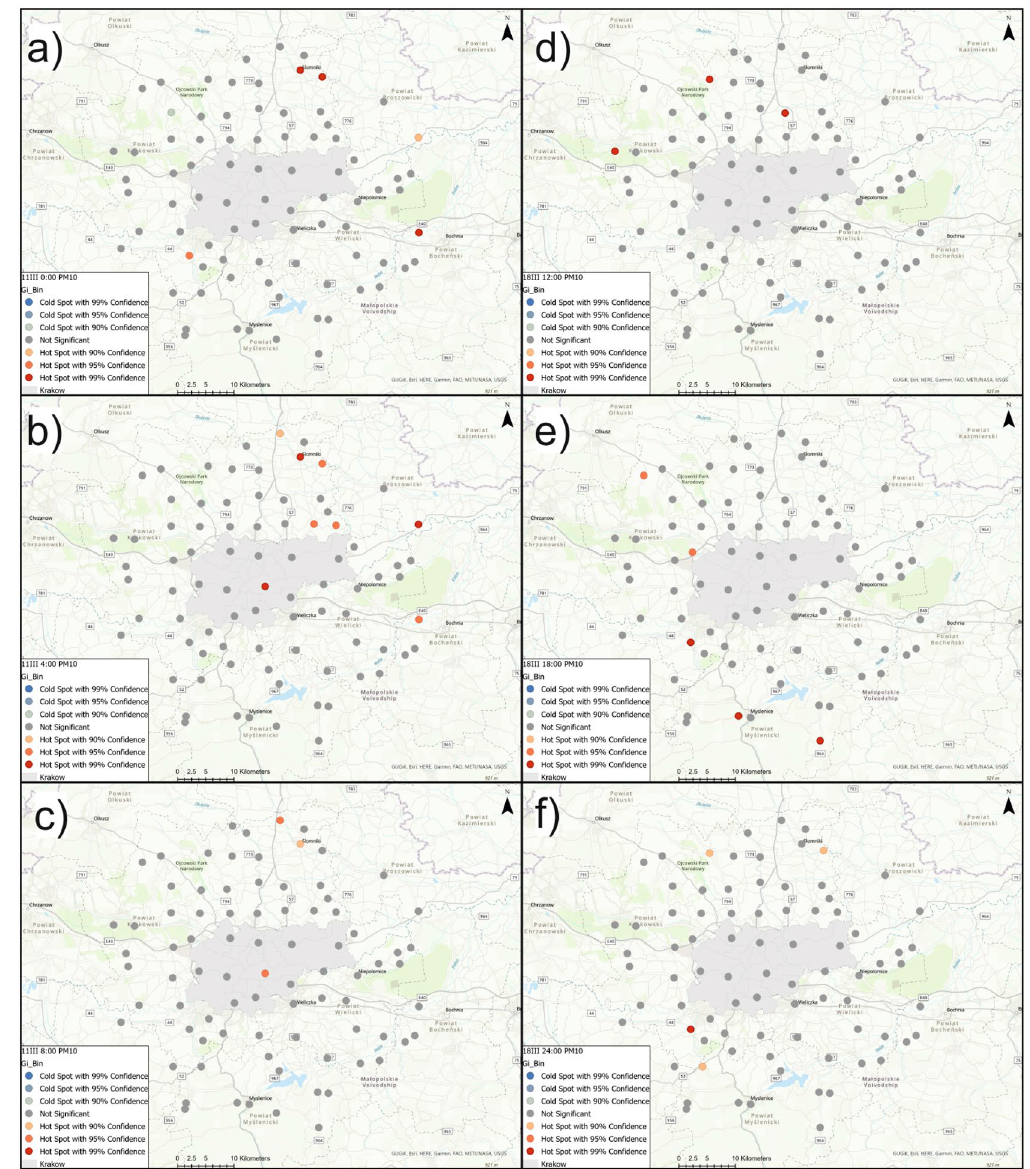
Figure 9. Hot-spots and cold-spots maps for PM10 con centration on March 11th and March 18th using Getis– Ord G